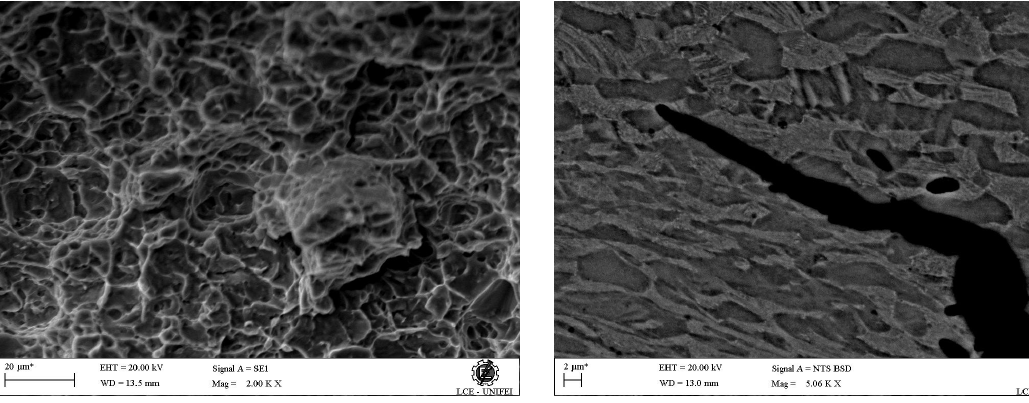
Figure 10. SCC Crack in DA Sample.